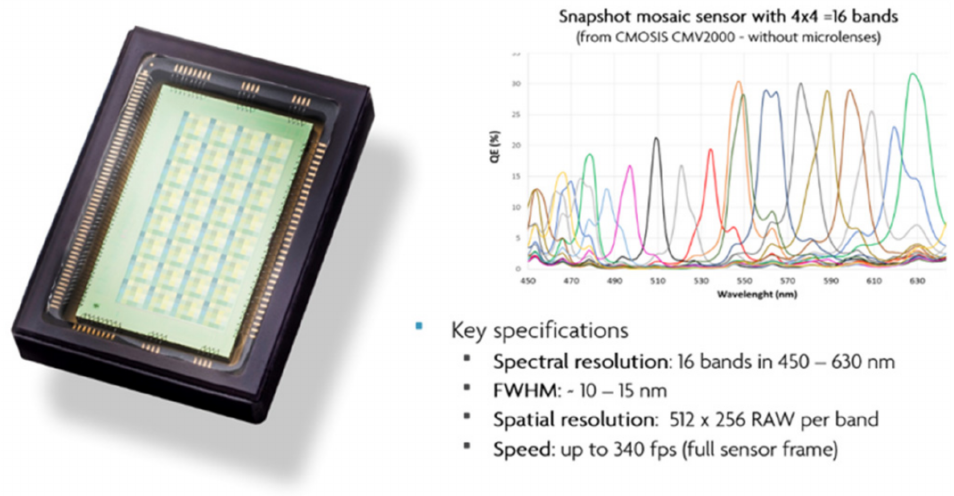
Figure 6. Example of one of our snapshot sensors and its spectral response. For this 16-band hyperspectral (HSI) sensor, the spectral filters are deposited in a 4 × 4 mosaic pattern across the pixels of the sensors. This enables acquisition of HSI data at video rate.